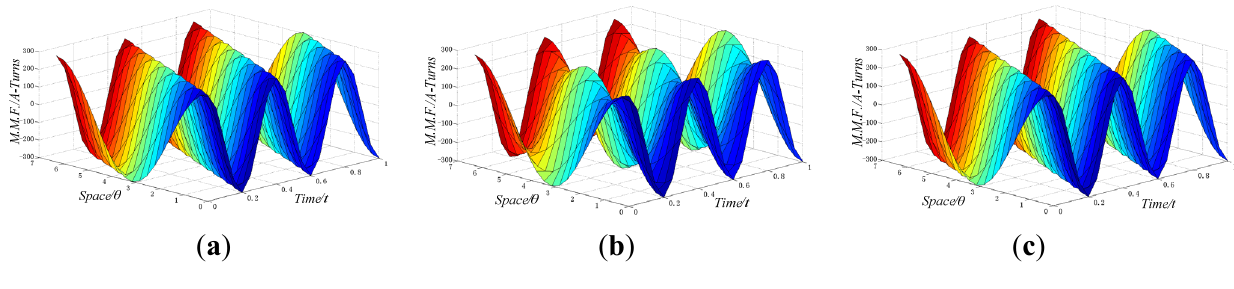
Figure 11. MMF distribution in time and space; ( a ) Healthy operation; ( b ) F phase open; ( c ) Fault-tolerant